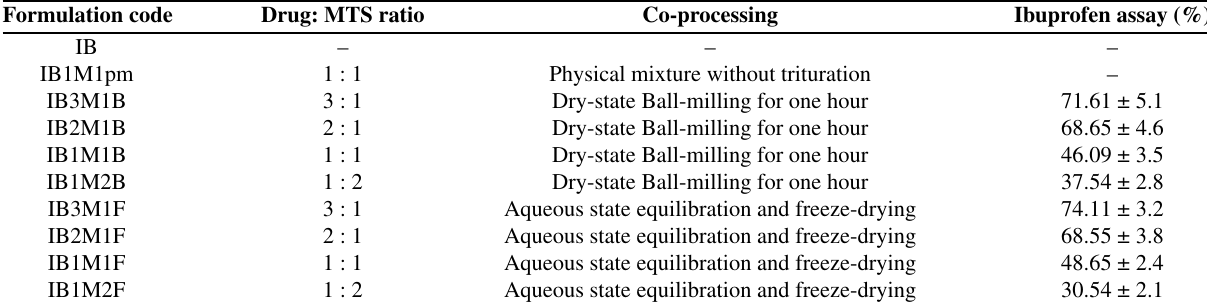
Table 1. Formulation code of ibuprofen samples co-processed with magnesium trisilicate (Ibuprofen = IB, Magnesium trisilicate = MTS). Formulation